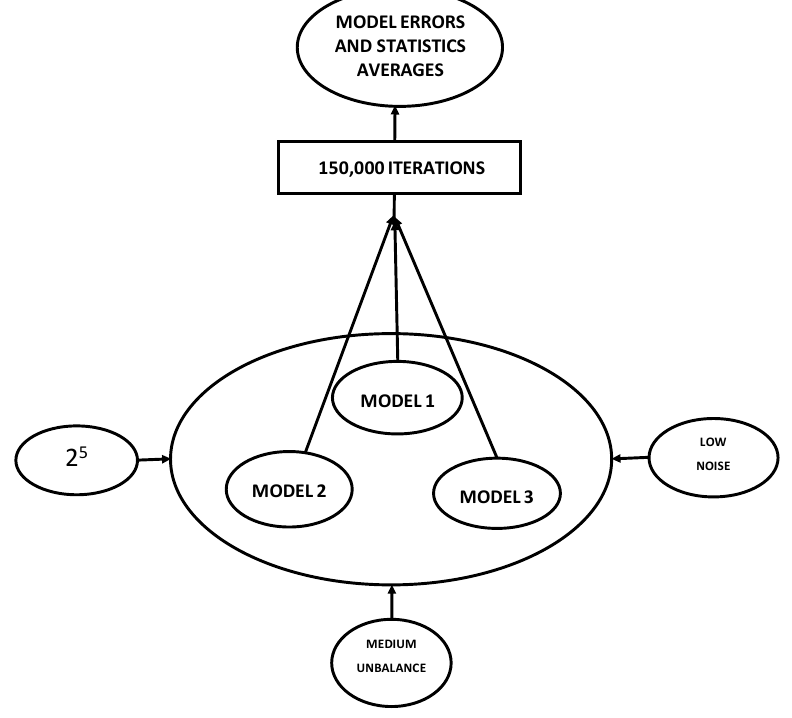
Figure 5. Simulation process.